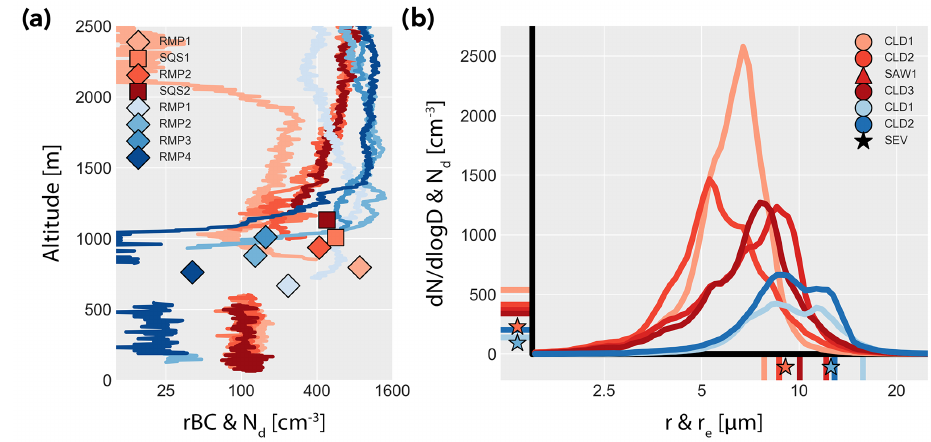
Figure 4. Cloud microphysical properties and rBC for the 31 August (red) and 4 September (blue) flights. (a) Vertical profiles of rBC number concentration (lines) and average N d (markers) for each RMP and SQS profile. The vertical positions of the markers indicate cloud-top height for each profile and the horizontal positions indicate the average N d value. Note that rBC and N d share the same x axis because they have the same units and similar magnitudes. (b) Average cloud droplet spectra (curves), N d (ticks on y axis), and r e (ticks on x axis) for each CLD and SAW leg. Stars indicate the values of N d and r e from SEVIRI (SEV) averaged over the 31 August (light red) and 4 September (light blue) flight paths.